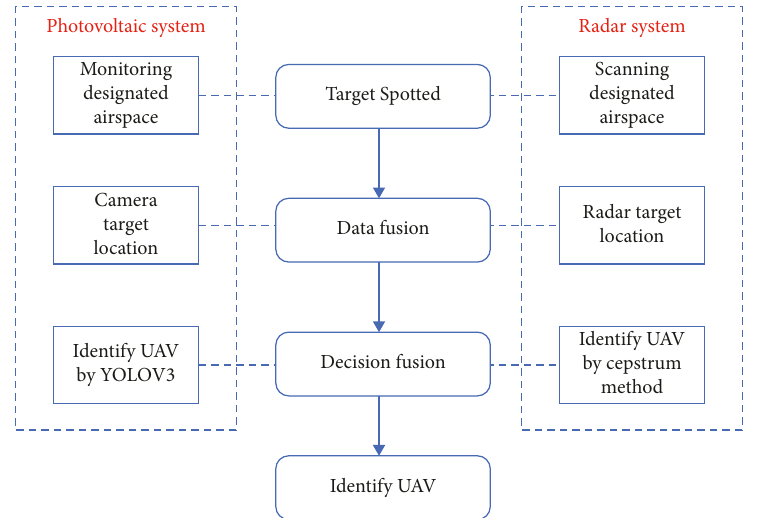
Figure 2: UAV identification system based on information fusion.